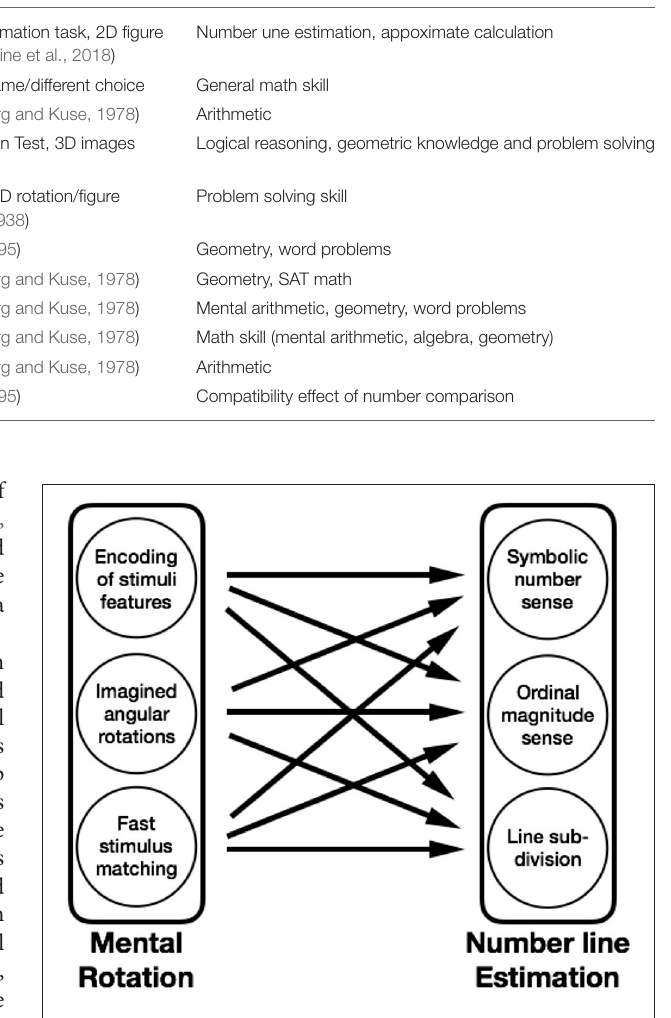
FIGURE 1 | Potential connections among spatial and mathematical skill